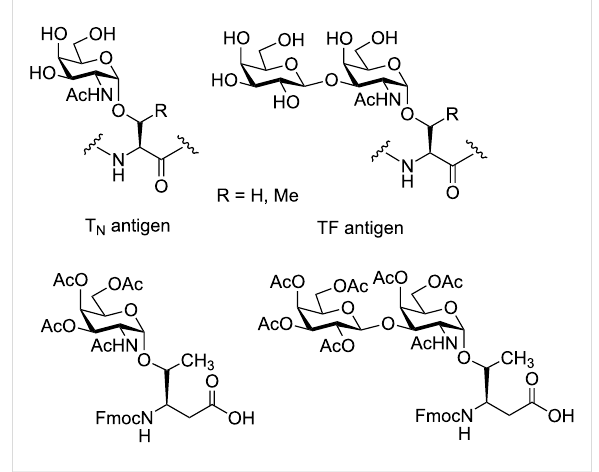
Figure 1: Structures of the naturally occurring T N and TF antigens and the targeted Fmoc- β 3 hThr analogues.